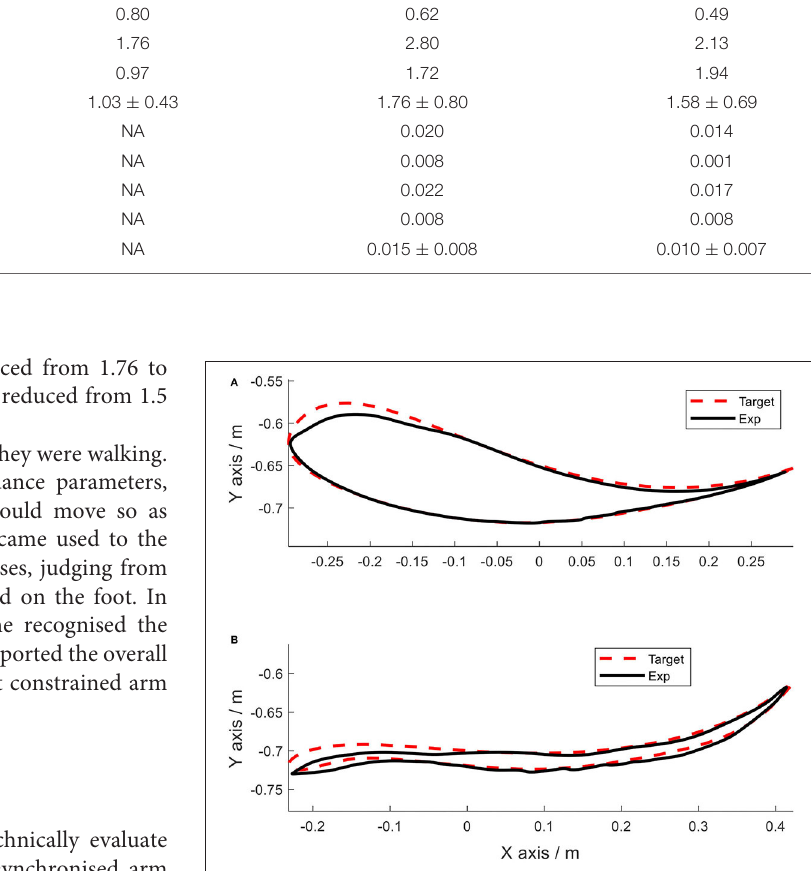
System with test person (low-gain parameters)